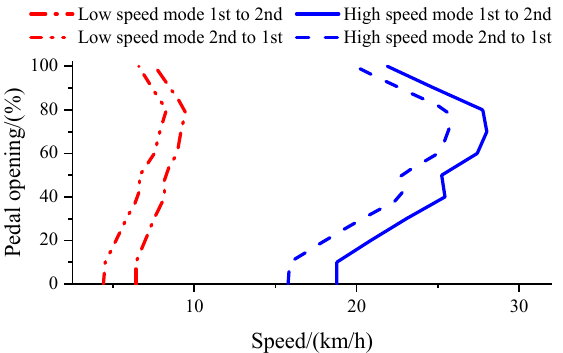
Figure 9. The optimal economy shift rule curve.